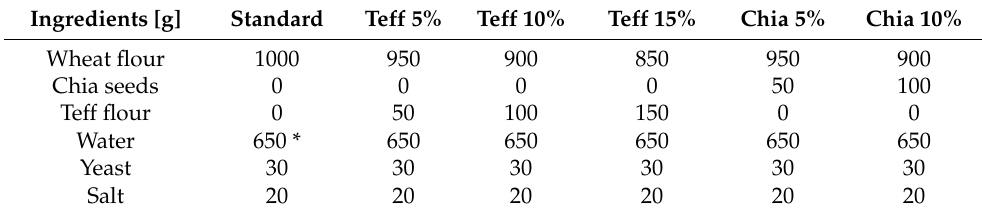
Table 1. Recipes of tested bread. Ingredients